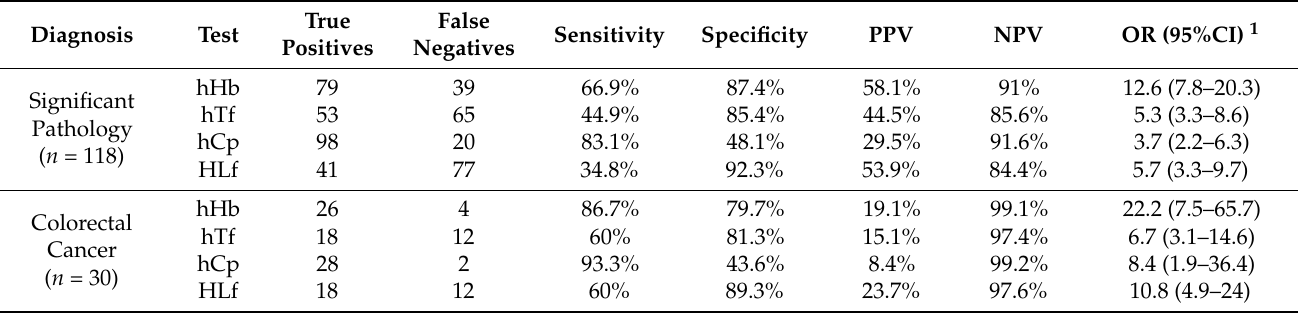
Table 3. Diagnostic accuracy of each biomarker of the combined POC faecal